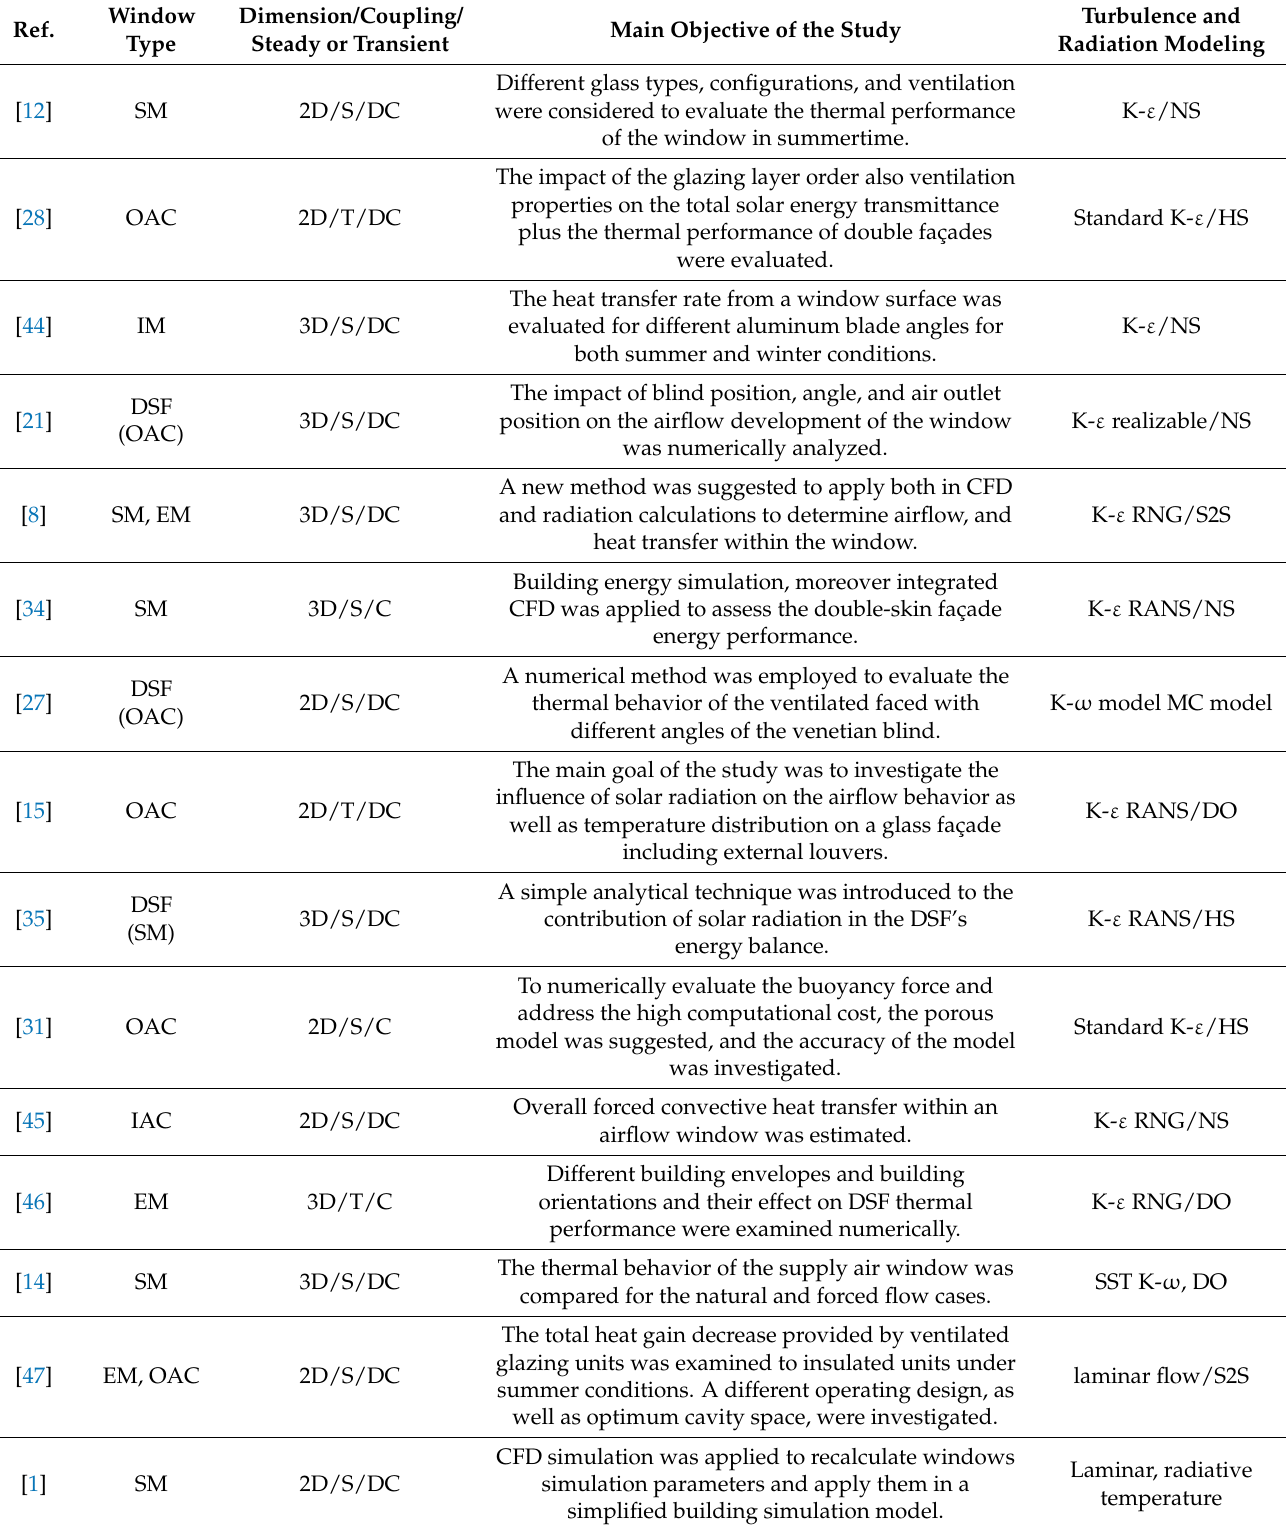
Table 1. Overview of ventilated window thermal performance studies based on CFD simulations.